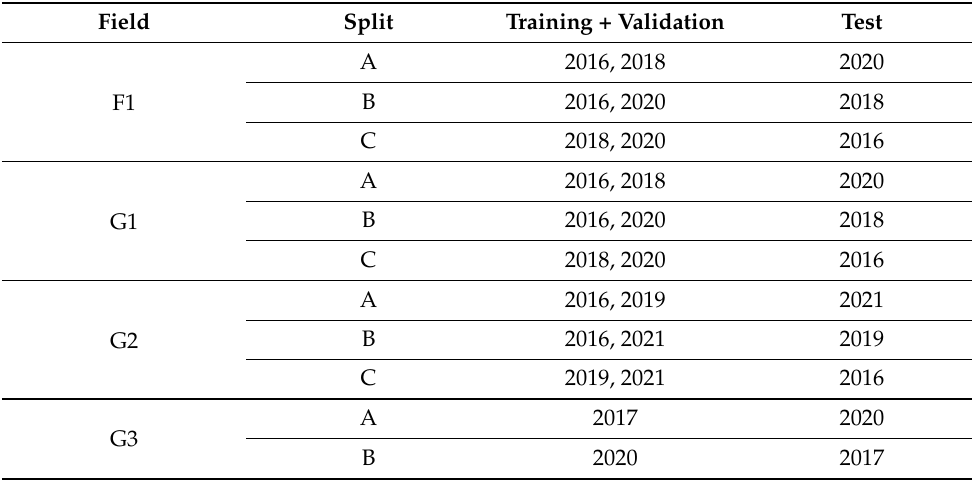
Table 2. Splits used to create the training, validation, and test